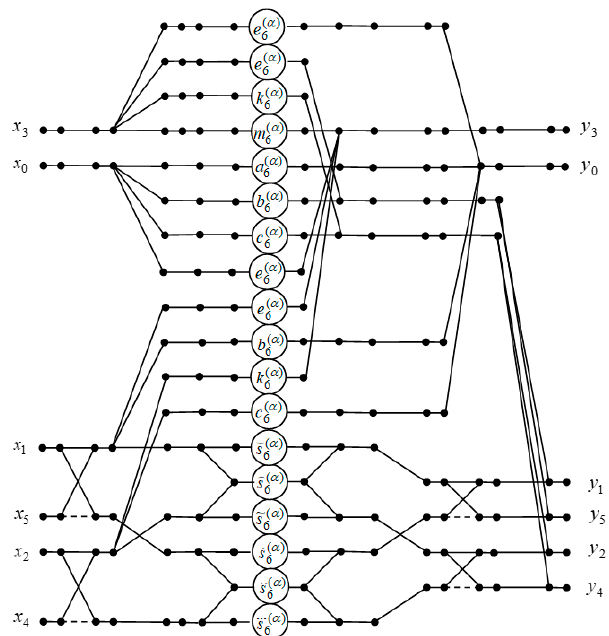
Figure 5. The data flow structure of the processing unit for the computation of the six-point